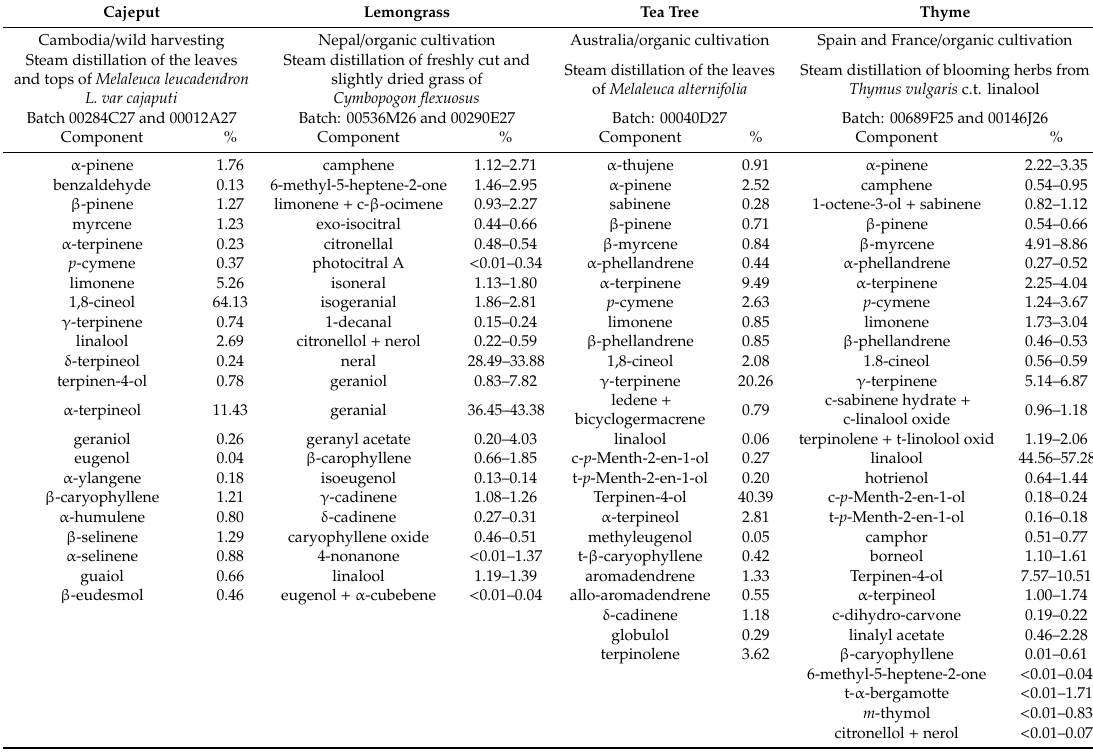
Table 1. Country of origin, type of cultivation and production, used batch numbers, and chemical composition * of the used essential oils according to the certificates of analysis of the manufacturer PRIMAVERA LIFE